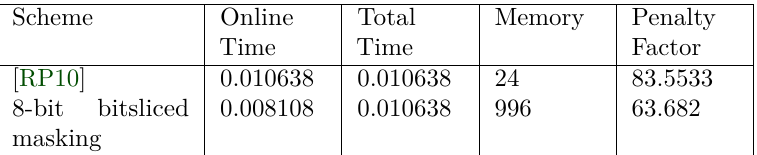
Table 7: Second-order S-box implementation of AES-128 with three input shares using the second-order circuit based schemes [RP10] with FullRefresh and 8-bit bitslicing. The execution times are in seconds. The RAM memory required is in bytes.